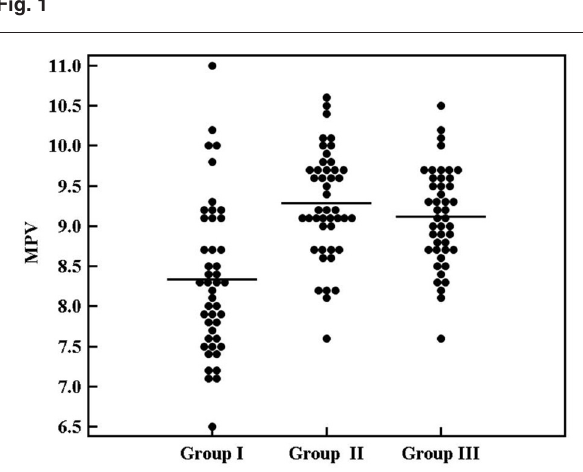
Comparison between the studied groups according to mean platelet volume (MPV) (in fl).